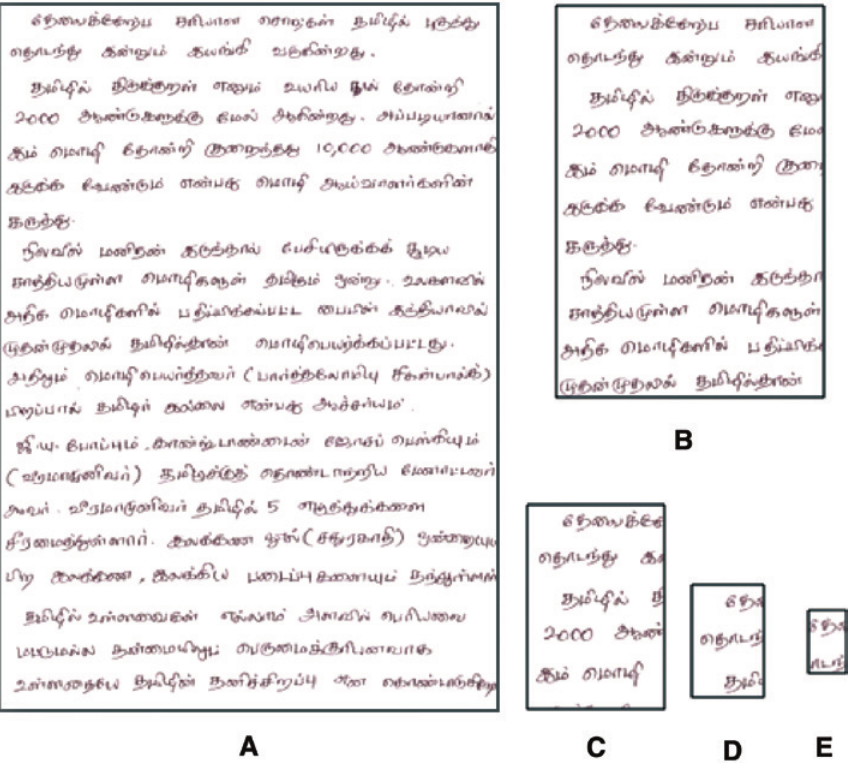
), (C) Second-Level ( L 1